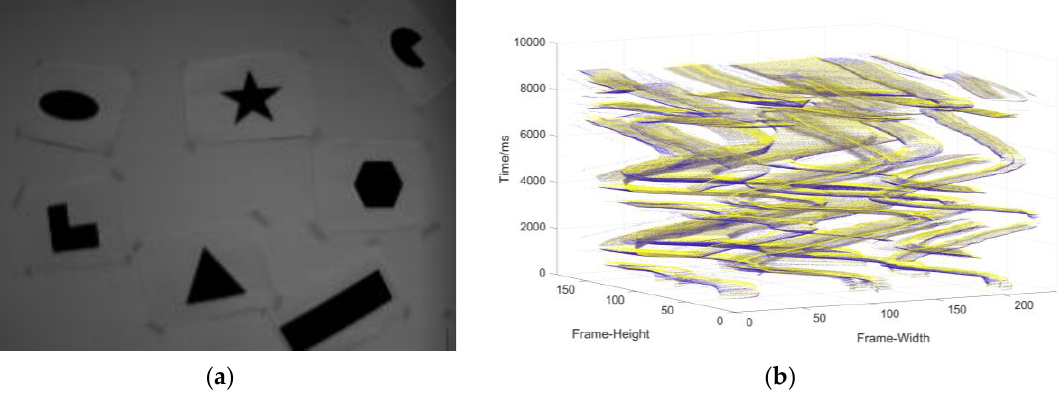
Figure 8. ( a ) The object used to generate the event stream; ( b ) three-dimensional spatiotemporal event stream generated by the object in ( a ).